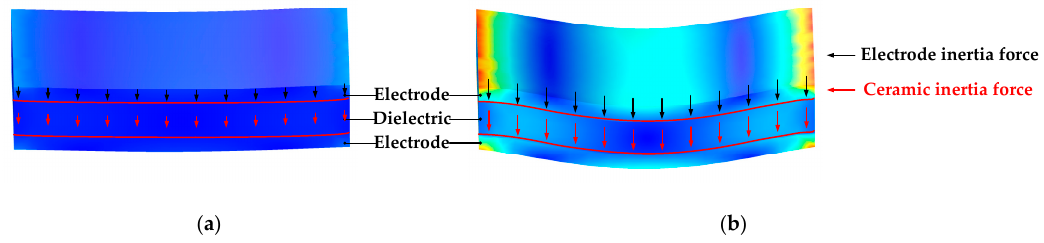
Figure 9. Deformation of the MLCC at different stages: ( a ) the first stage; ( b ) the second stage. Table 3. Simulation capacity change of the MLCC under different impacts.